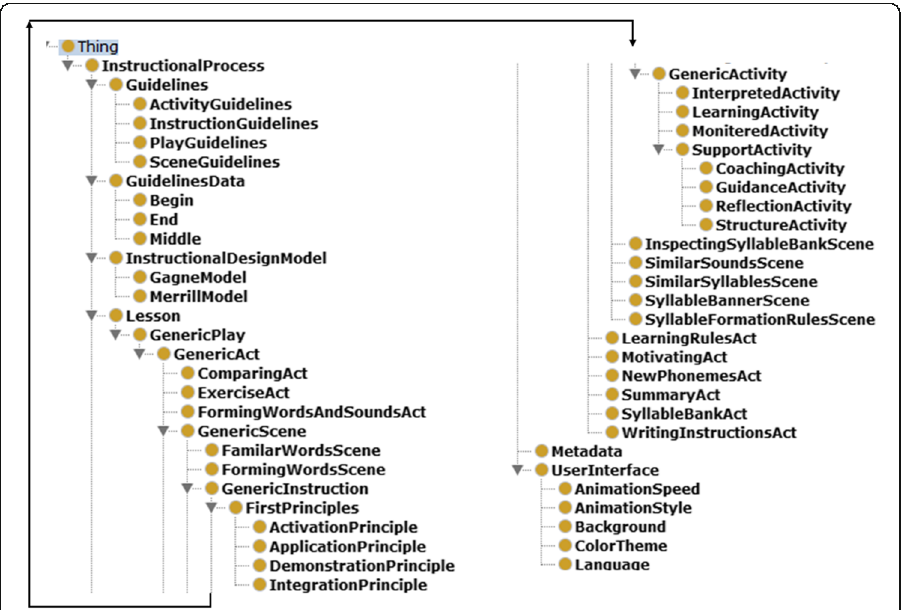
Fig. 7 A fragment of